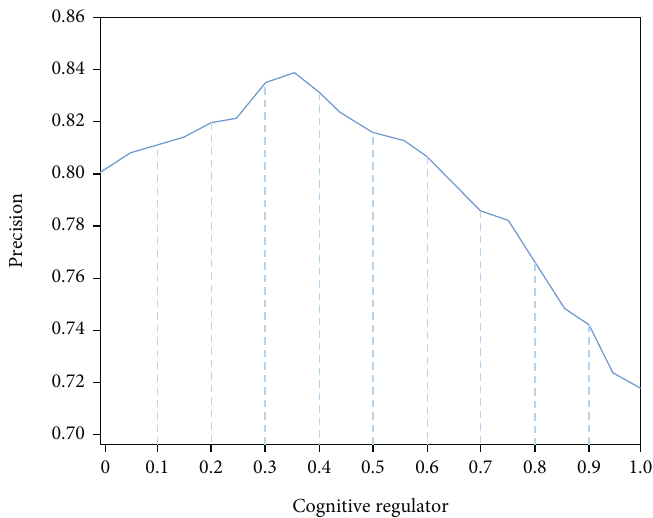
Figure 4: The results of frcsub dataset exercise recommendation model under di ff erent parameter values.